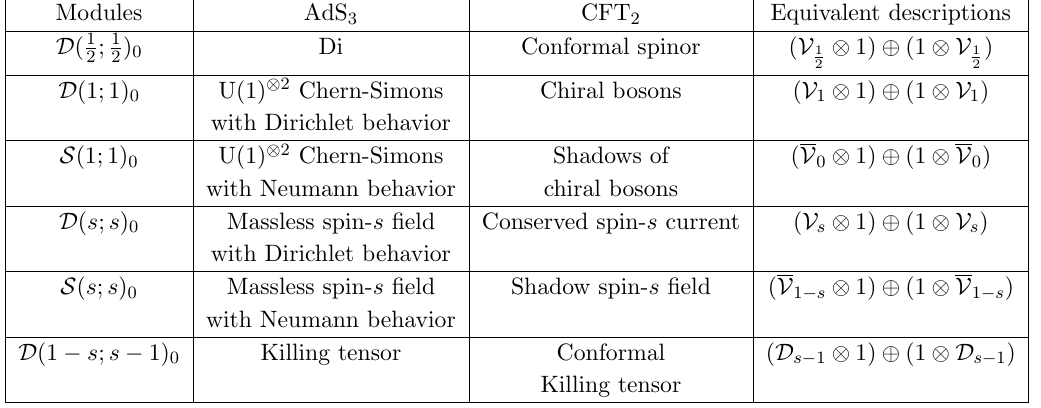
Table 2 . List of relevant so (2 ; 2) modules and their (cid:12)eld-theoretical